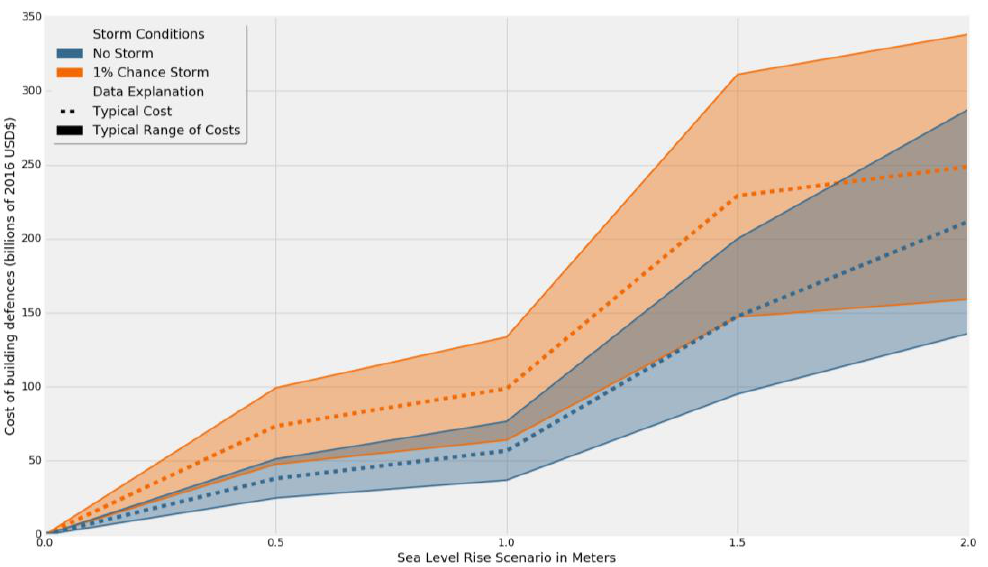
Figure 11. Figure showing the average and the range of potential costs under two different design scenarios for Shoreline B. The lines in blue show a scenario that assumes protective infrastructure would be designed to address only future sea level rise and not storm events. The lines in orange assume that protective infrastructure would be designed to address the 1% chance storm event as well as sea level rise. Costs are based on current infrastructure type—landform or wall—being raised to meet future water levels for sea level rise scenarios between 0 m and 2 m. The cost estimates are done using Approach 3: complex cost approximations without parcel values and are shown as billions of 2016 USD$.